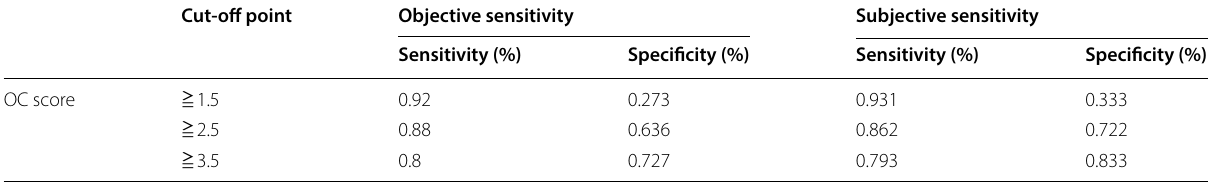
OC score, olfactory cleft